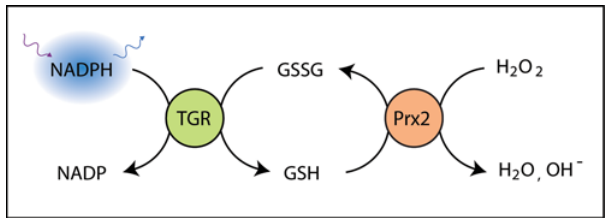
Figure 1. TGR/Prx2 assay principle.